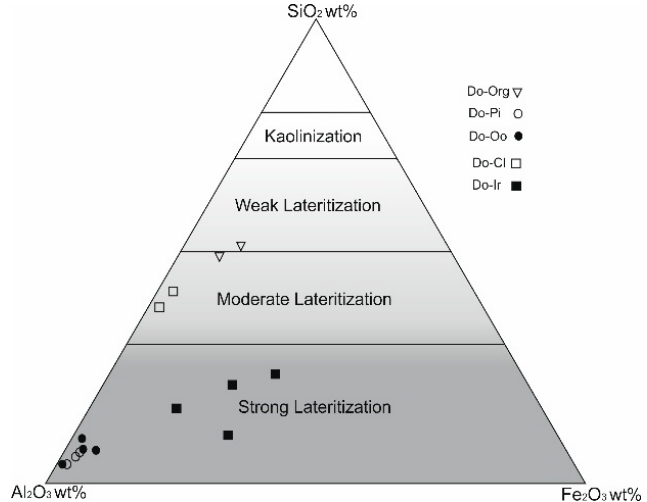
Figure 6. Ternary plot of the SiO 2 –Al 2 O 3 –Fe 2 O 3 system (after [50]) showing the intensity of lateritization of the Dopolan bauxites.